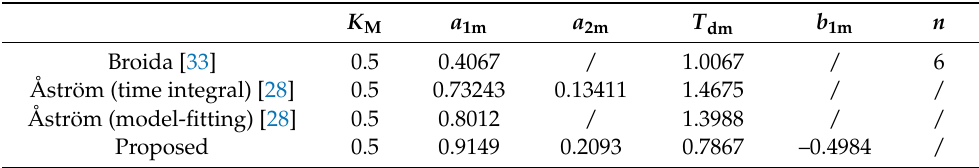
Table 6. The estimated model parameters for the process G P3